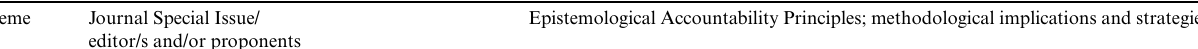
Table 1 . Principles of epistemological accountability and methodological coherence when measuring, assessing, and/or profiling human